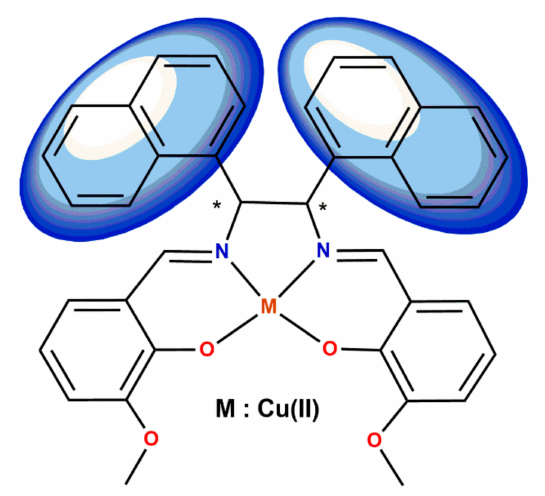
Figure 4. Chiral salen-type Schiff base Cu(II) complexes with π -conjugated ligand (* denotes an asymmetric carbon atom)